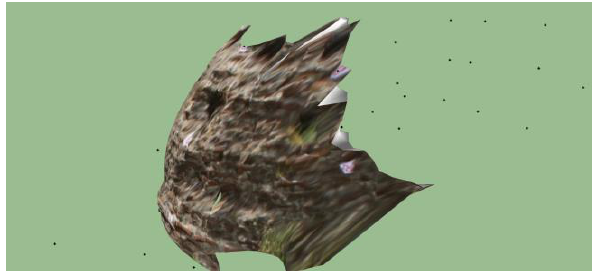
Figure 11. Distortion of surface material position of grass due to breeze during shooting. Cutting grass on the surfaces prior to shooting is